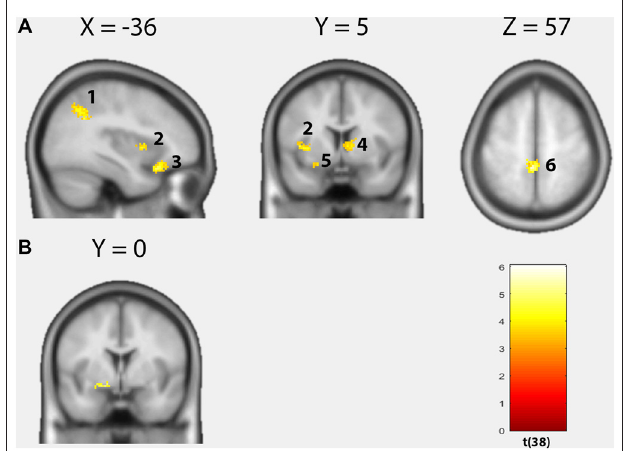
FIGURE 2 | Results of the voxel-wise regression analysis. (A) Positive correlations between the Tampa Scale of Kinesiophobia (TSK) score and brain activity based on the contrast “harmful movements > neutral movements” ( p < 0.05, cluster-level FWE-corrected). [1] Left angular gyrus, [2] left insula, [3] left orbitofrontal cortex (OFC), [4] right caudate, [5] left amygdala, [6] left postcentral gyrus/precuneus. (B) Significant group difference as a function of the TSK score in the left dorsal amygdala (Interaction 0 0 1 − 1; p < 0.001,